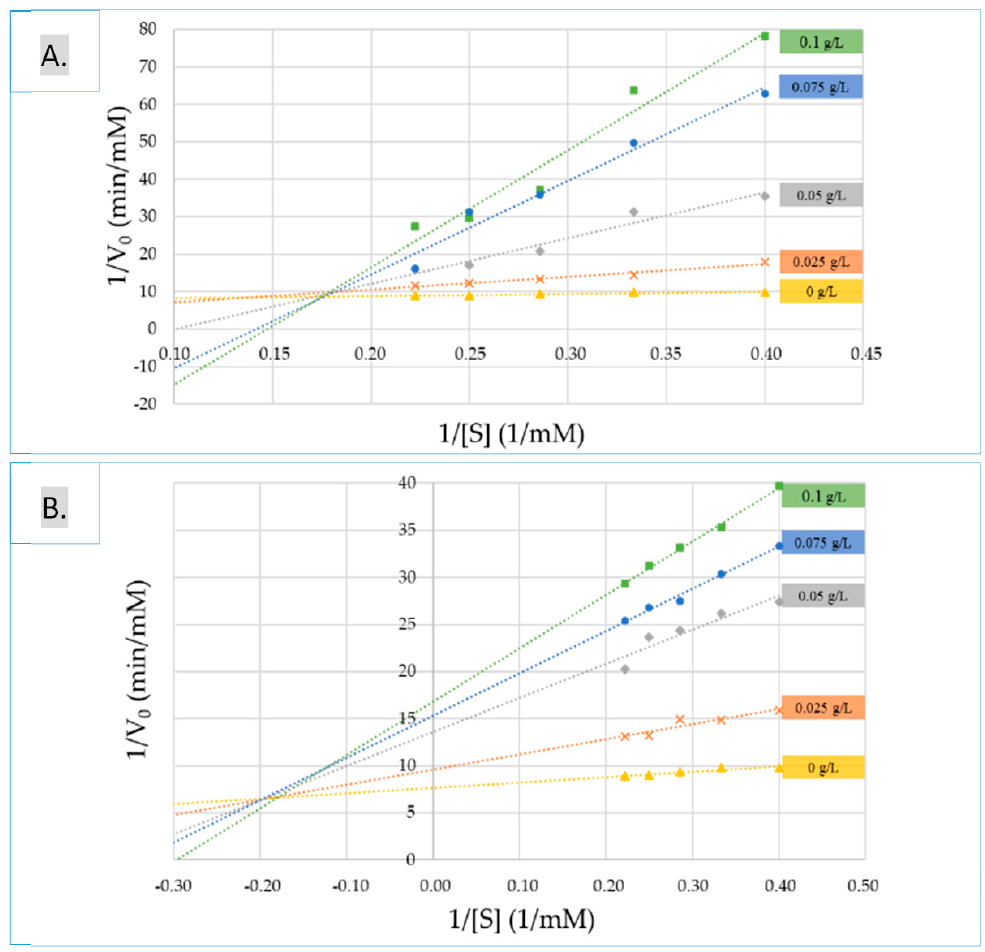
Figure 3. Lineweaver-Burk double reciprocal plots of ( A ) skin and ( B ) seed extracts at the first stage of ripening for the α -glucosidase activity mode. Table 4. Kinetic parameters of α -glucosidase inhibitory capacity by skin and seed extracts at the first stage of ripening.